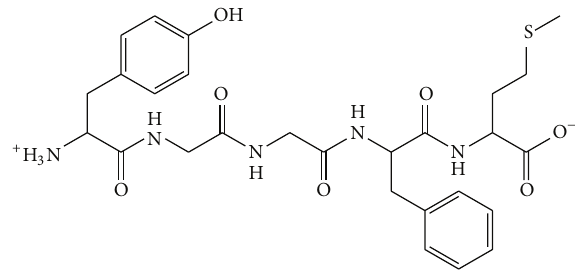
Figure 1: Structure of